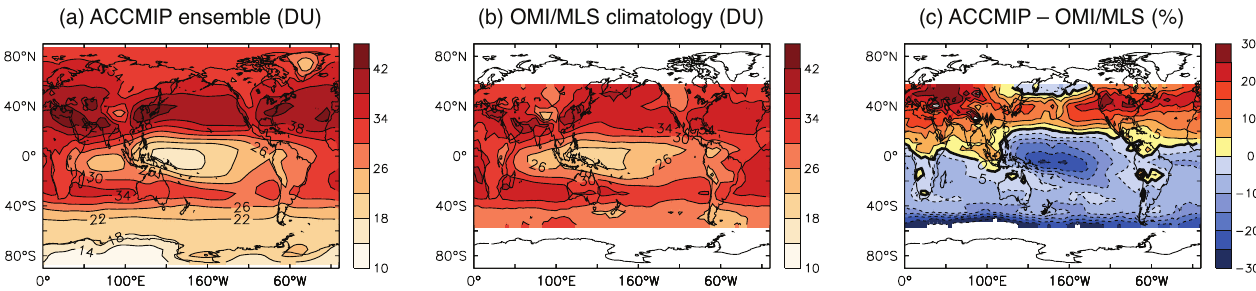
Fig. 6. Comparison of the annual mean tropospheric ozone column between (a) the ACCMIP ensemble (different tropopause compared to Fig. 2d) and (b) a climatology derived from the Ozone Monitoring Instrument (OMI) and Microwave Limb Sounder (MLS) by Ziemke et